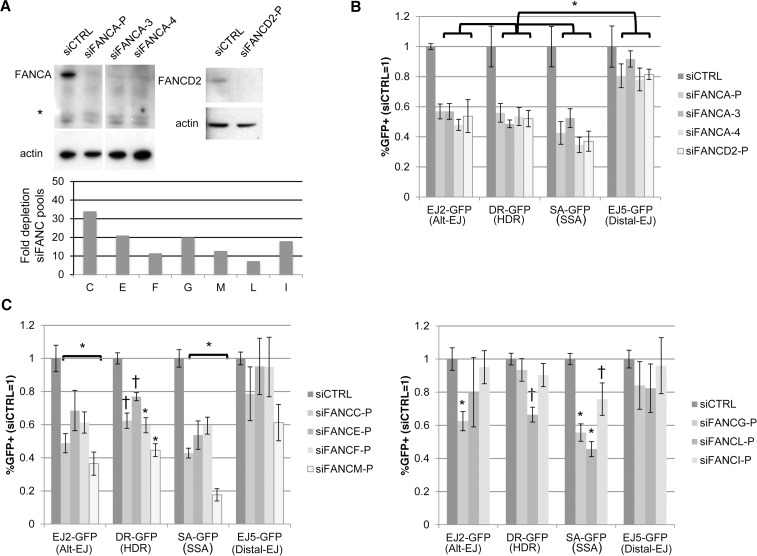
Several other FANC factors show a similar influence as FANCA on Alt-EJ and HR.(A) Targeting FANC genes with siRNA. Shown are immunoblot signals from U2OS cells treated with siCTRL, FANCA siRNA pool (siFANCA-P), two individual siRNAs from the siFANCA pool (siFANCA-3 and siFANCA-4), and a FANCD2 siRNA pool (siFANCD2-P). *indicates nonspecific band. Also shown is the fold decrease in target mRNA after the respective siRNA treatment, as quantified by qRT-PCR (2ΔΔCt, based on normalization to actin and siCTRL treated cells, as in Fig. 1D), for siRNA pools of seven FANC genes (C, E, F, G, M, L, and I). (B) Analysis of Alt-EJ, HDR, SSA and Distal-EJ after depletion of FANCA and FANCD2. Shown are GFP+ frequencies of U2OS cells treated with siRNAs from A and analyzed as in Fig. 2B. *P≤0.003 distinct from the effect of each siRNA on Distal-EJ (n≥4). (C) Analysis of Alt-EJ, HDR, SSA and Distal-EJ after depletion of the other FANC factors (C, E, F, G, M, L, and I). Shown are GFP+ frequencies of U2OS cells treated with siRNAs from A and analyzed as in B. *P<0.01 distinct from the effect of each siRNA on Distal-EJ (n = 6). †P<0.04 distinct from the effect of each siRNA on Distal-EJ (n = 6).